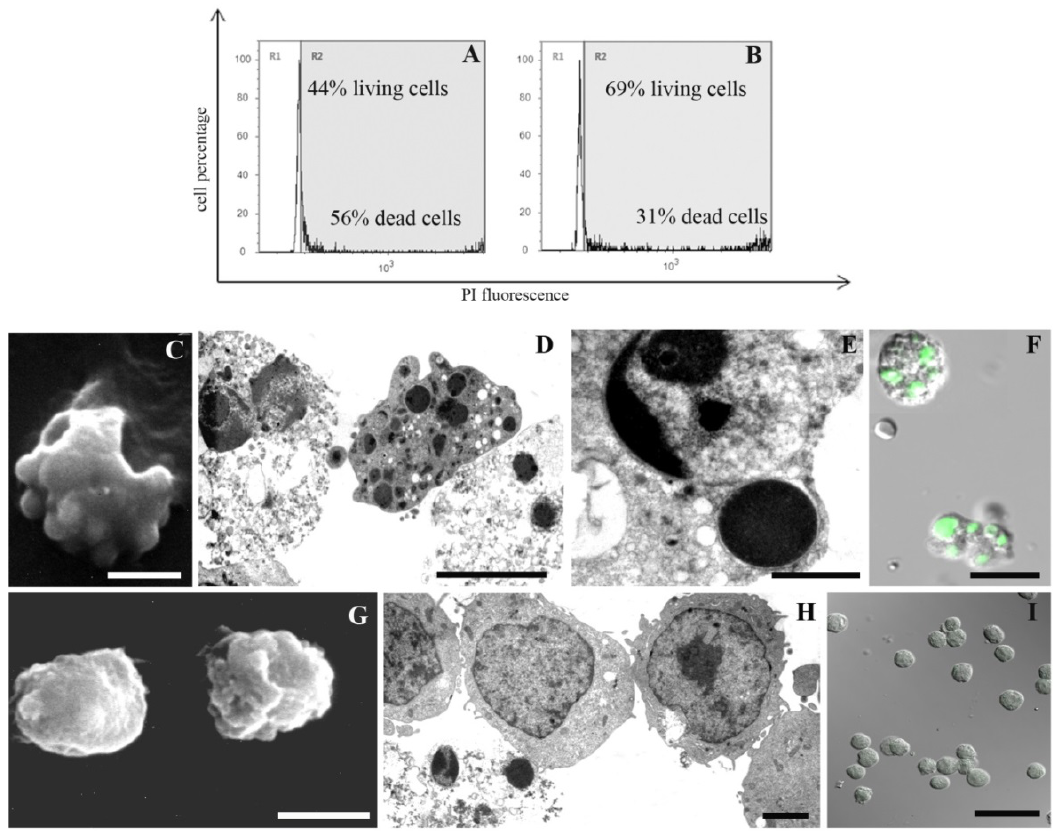
Figure 2. Cells exposed to H O ( A , C – F ) or MEL+ H O ( B , G – I ), analysed by means of 2 2 2 2 supravital PI, SEM, TEM and CLSM, prove a cell viability decrease ( A ) in the presence of morphological apoptotic patterns: membrane blebbing ( C ), micronuclei ( D , E ) and necrotic cell death ( D ). In addition, several positive nuclei appear after TUNEL reaction ( F ). MEL administration is able to ameliorate cell viability ( B ) and to reduce apoptotic events ( G – I ). Scale bars: ( C , D , F , G ) 5 µm; ( E , H ) 2 µm; ( I ) 10